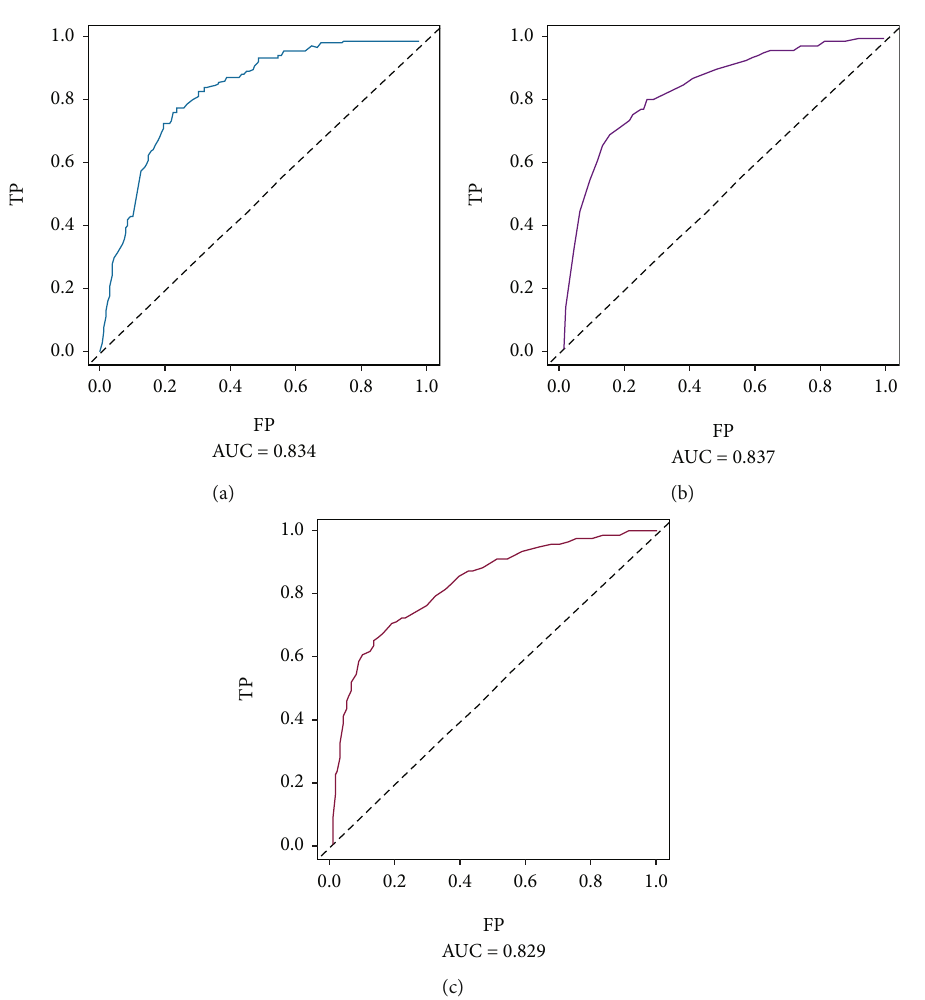
Figure 5: The ROC curves of validation dataset: (a) the mortality within one year; (b) the mortality within three years; (c) mortality within fi ve